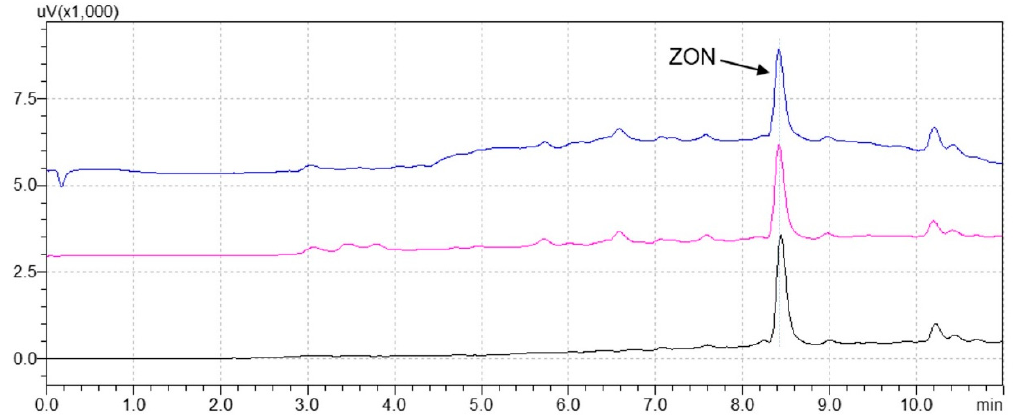
Figure 4. Chromatograms of a refined maize oil sample spiked with 200 µ g / kg of ZON after extract clean-up with (blue trace) QuEChERS, (pink trace) liquid–liquid extraction (LLE), and (black trace) MIP-SPE.